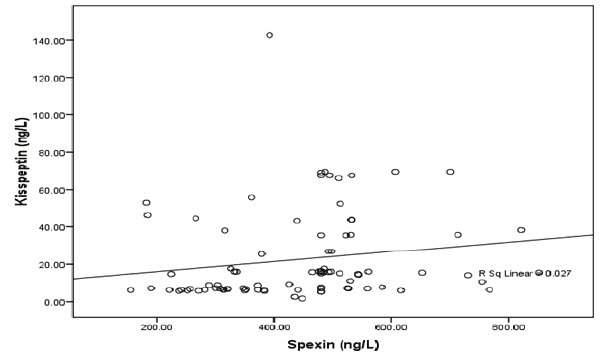
Figure-I: Comparison of mean serum levels of kisspeptin and spexin in subjects with normal and altered sperm parameters.